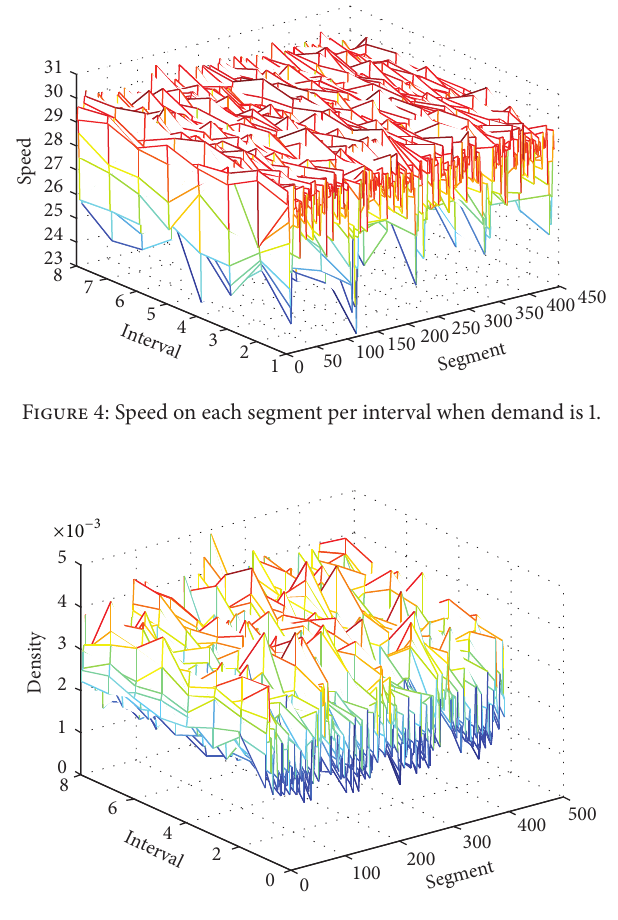
Figure 5: Density on each segment per interval when demand is 3.